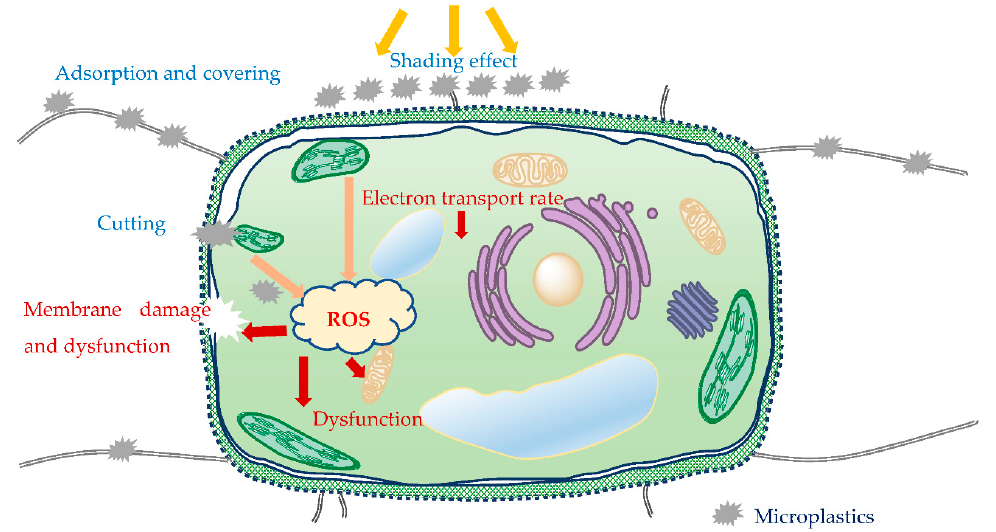
Figure 2. Schematic description of the toxicity mechanisms of microplastics to algae cell. Apart from the mechanical damage, microplastics are expected to reduce the pho-